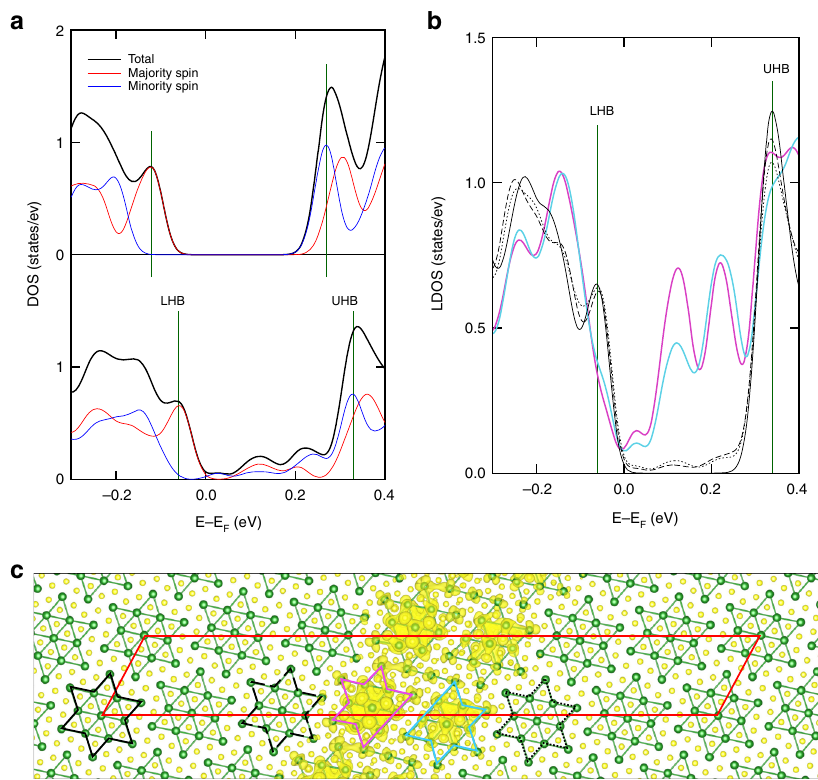
Fig. 3 Density of states and charge character of DW-1. a Normalized total DOS of the C-CDW phase (upper panel) as a reference and DW-1 structure (lower panel). Vertical green lines denote the upper and the lower Hubbard band (UHB and LHB). b Local DOS at all Ta atoms in each David star of DW-1 structure. Each David star is denoted by solid and dashed line (domain center and edges) and colors (domain wall) in c . c Charge characters in the energy range from 0 to 0.2